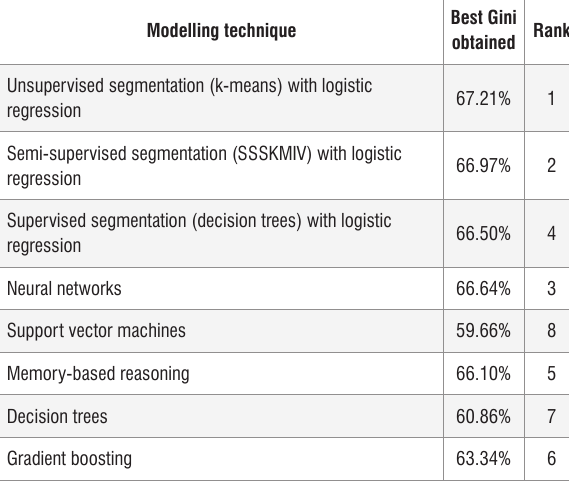
Table 5: Wine quality data set: Comparison of performance Modelling technique